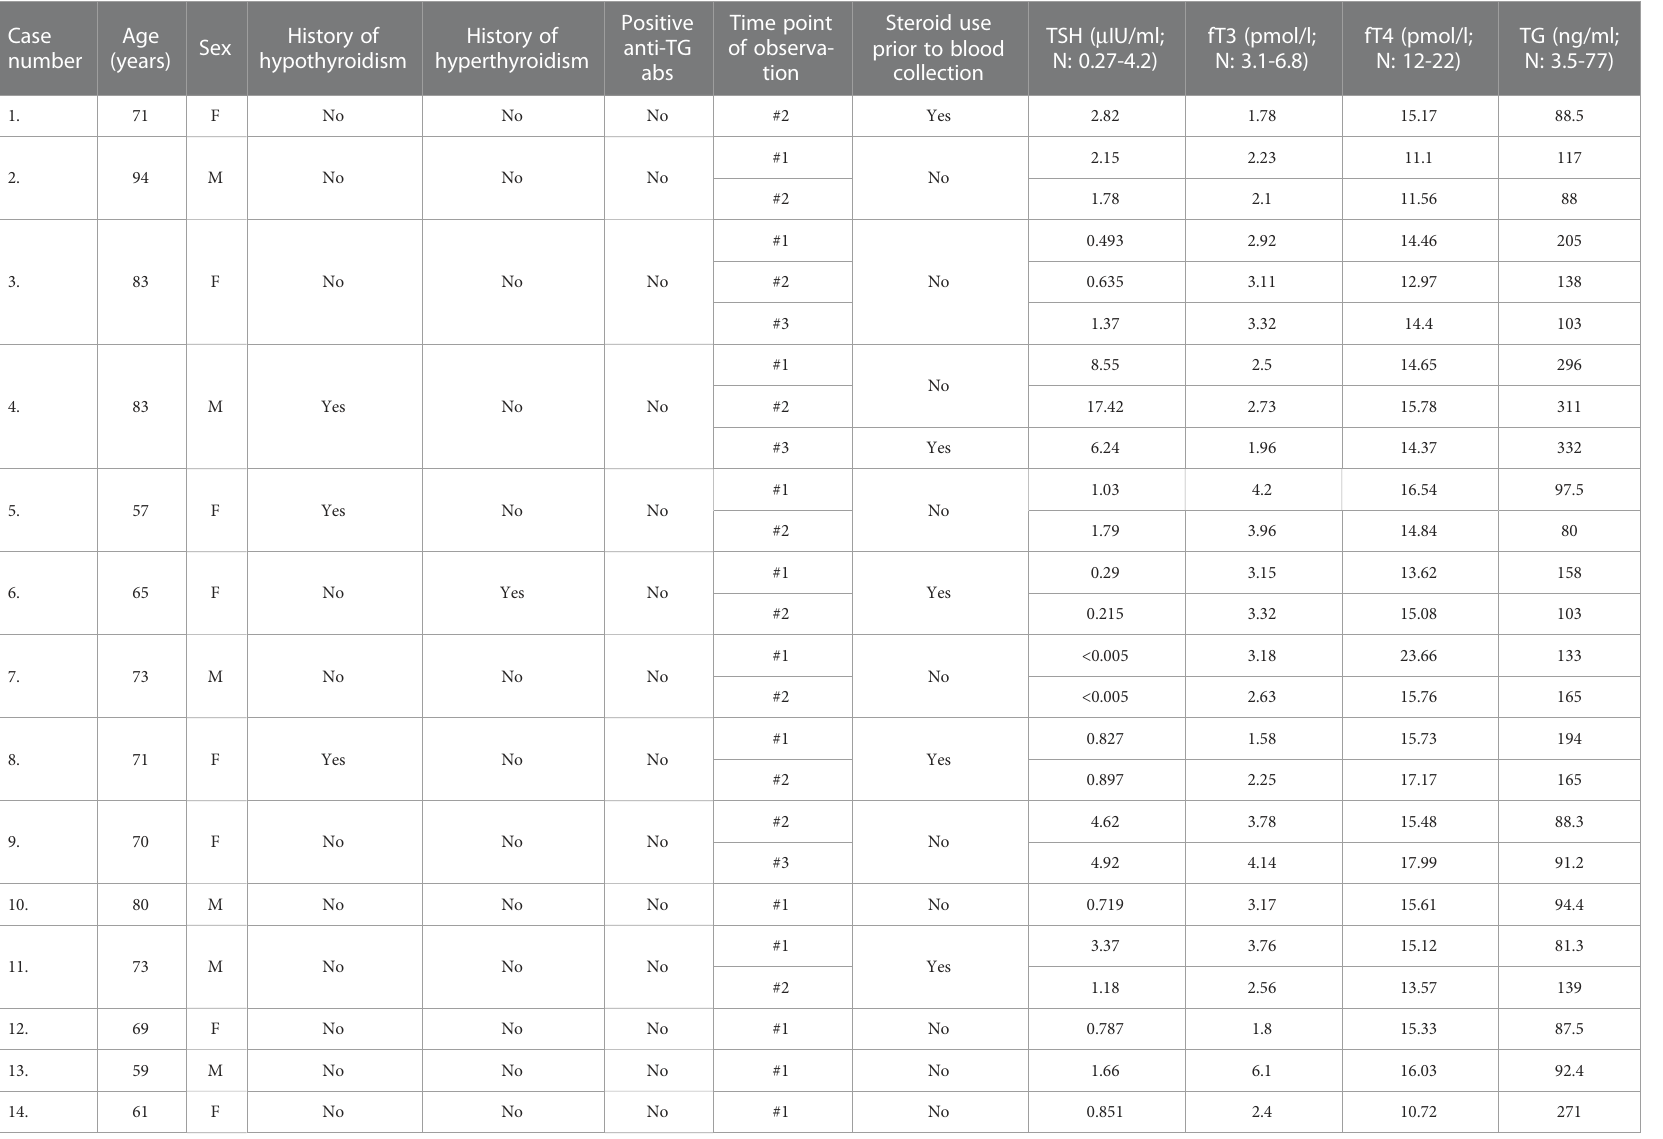
TABLE 5 Summary of patients who showed elevated